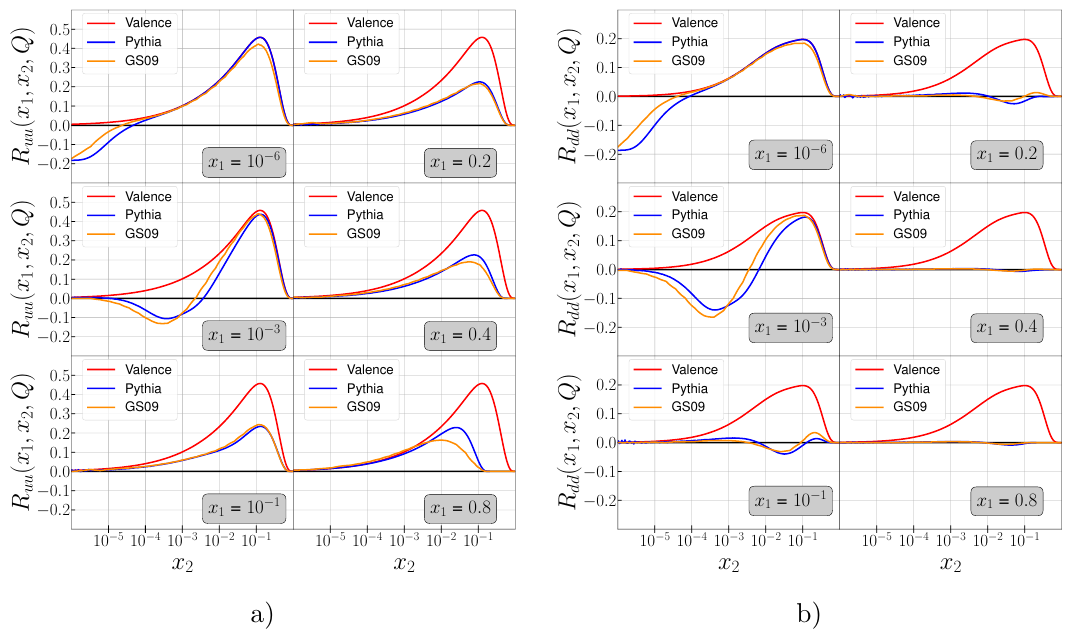
Figure 2 . The responses of the valence quarks as functions of x 2 at fixed x 1 . The factorization scale Q = 91 GeV. Comparison between the GS09 and P YTHIA dPDFs: a) R uu ( x 1 , x 2 , Q ) response function, b) R dd ( x 1 , x 2 , Q ) response